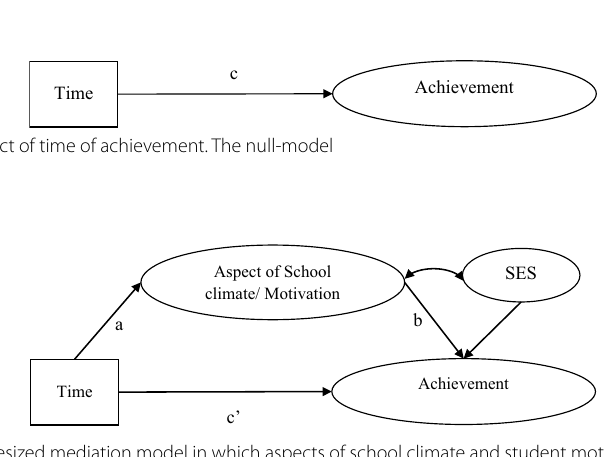
Fig. 2 Hypothesized mediation model in which aspects of school climate and student motivation and self‑concept mediate the effect of time on